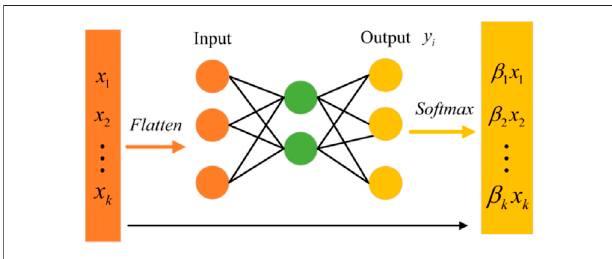
FIGURE 2 | Attention mechanism